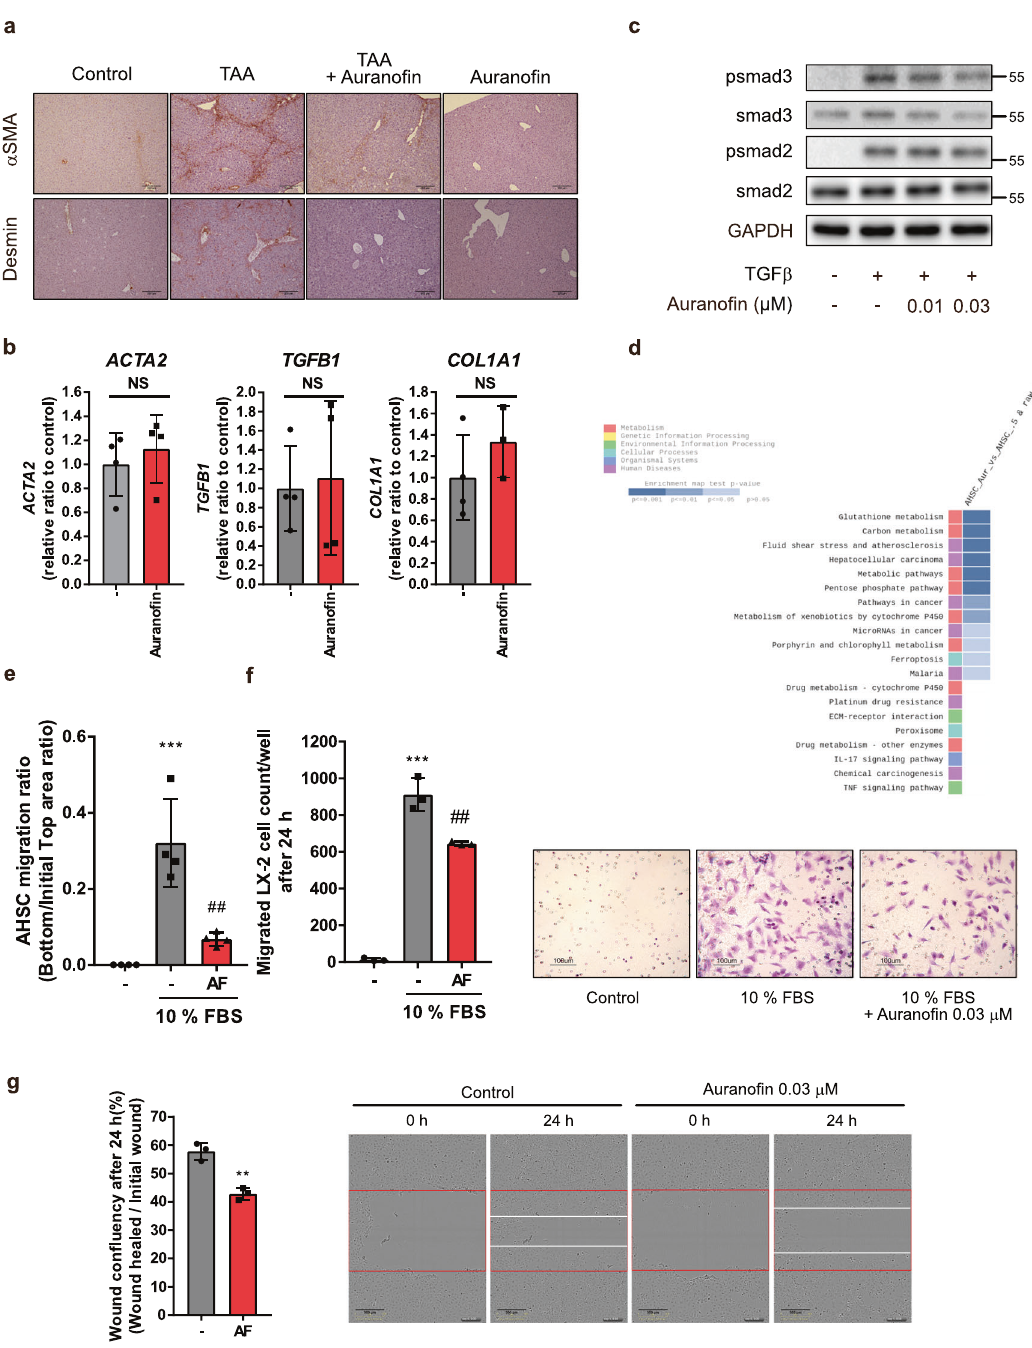
Fig. 4 Aurano fi n inhibits migratory ability of activated HSCs. a α SMA and desmin stained liver sections showing distribution of hepatic stellate cells in TAA injected mice. Scale bar = 200 µ m. b Isolated primary mouse HSCs were cultured on uncoated plastic plates in the presence of serum and aurano fi n (0.03 µ M) containing media. HSCs activation markers including ACTA2, TGFB1 , and COL1A1 were evaluated after incubation for 7 day, n = 4. NS; not signi fi cant. c Smad2/3 phosphorylation following treatment of TGF β 1 (5 ng/ml) and aurano fi n for 1 h. d KEGG pathways analysis based on gene enrichment database. RNA samples for RNA sequencing were isolated from primary HSCs exposed to vehicle or 0.03 µ M aurano fi n for 12 h were used. e Migration of HSCs was measured by Incucyte ® chemotaxis assay, n = 4. f Migration of LX-2 measured by transwell assay. Migrated LX-2 cells were stained with 0.1% crystal violet and counted per well, n = 3. Data are presented as mean ± SD ( c , e , and f ), analyzed by one-way ANOVA followed by Tuckey ’ s test; *** p < 0.001, compared to control; ## p < 0.01 compared to chemoattractant (10% FBS) added group. Scale bar = 100 µ m. AF; aurano fi n 0.03 µ M. g Effect of aurano fi n on wound healing of LX-2 cells. Scratch closure changes were measured after creating wounds on cells using 96-well ImageLock plate and incubation with aurano fi n-containing media, n = 3. Scale bar = 300 µ m. Data are presented as mean ± SD, analyzed by unpaired student ’ s t -test. AF; aurano fi n 0.03 µ M, ** p < 0.01 compared to healed wound con fl uency of